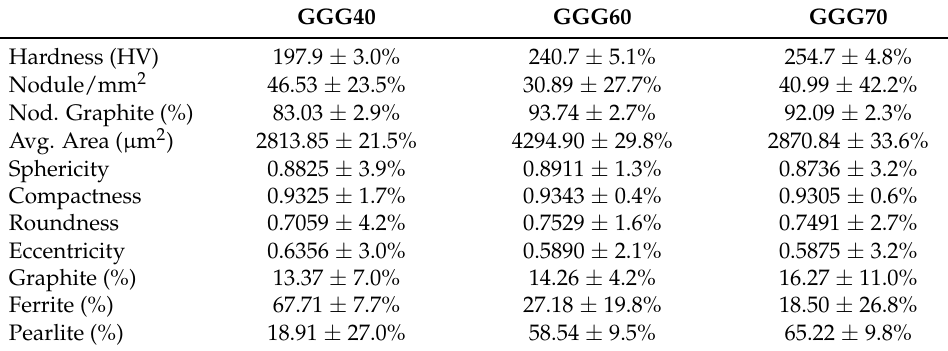
Table 5. Final results averages for NCI GGG40, 60 and 70 block